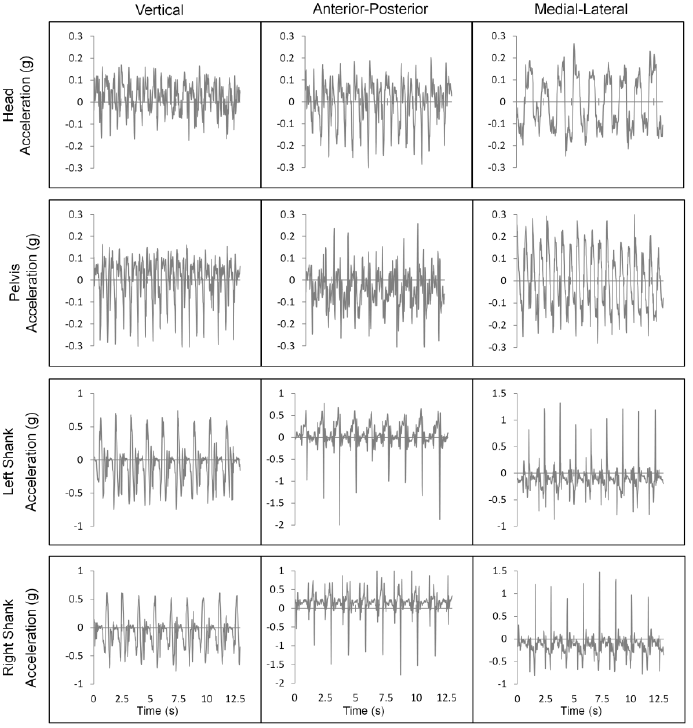
Figure 2. Typical accelerometer signals for ST gait for all accelerometer locations: head, posterior pelvis, left shank, and right shank. For the vertical axis, positive is upwards/superior; for the AP axis, positive is anterior; for the ML axis, positive is toward the participant’s right [36].